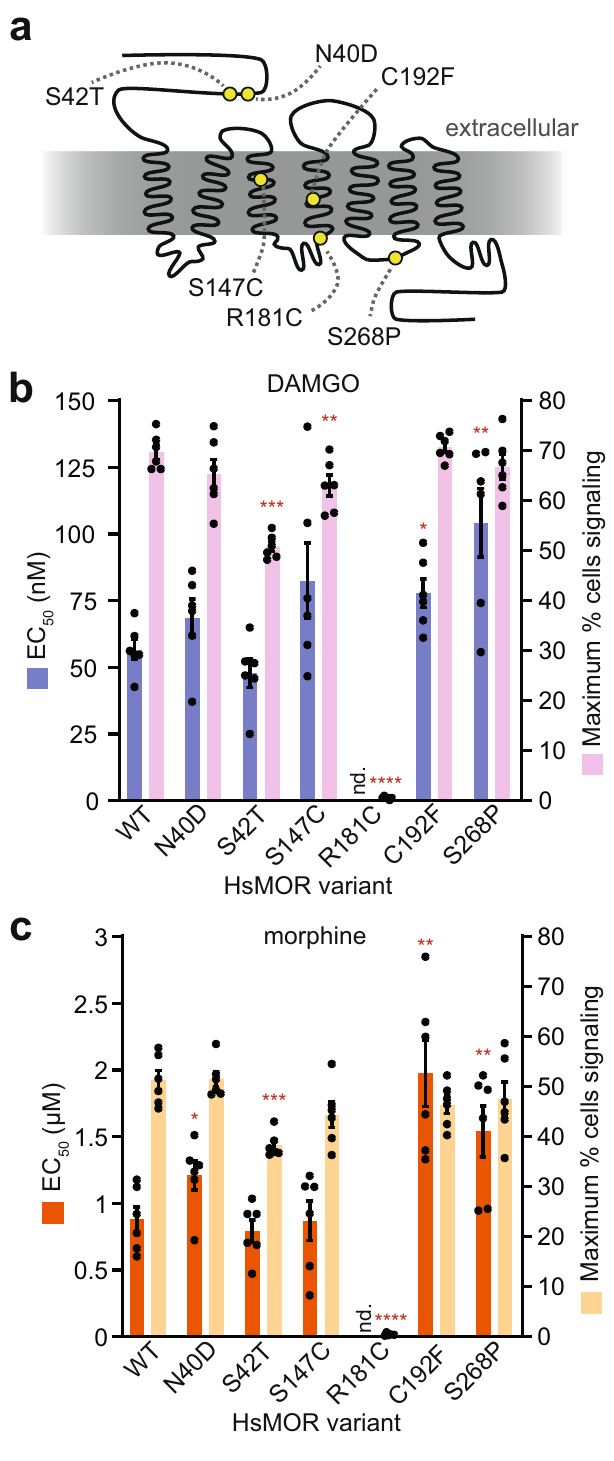
Fig. 4 The effects of HsMOR missense mutations on opioid biosensor activity. a HsMOR snake plot with previously identi fi ed missense mutations. Biosensors based on these mutants were assayed for DAMGO response ( b ), or morphine response ( c ), by fl ow cytometry. Paired one-way ANOVAs of DAMGO pEC 50 s and maximum percentage of cells signaling: n = 6 biologically independent experiments, >2956 cells/condition/ replicate; P = 0.0002 and P < 0.0001 respectively; Dunnett ’ s tests against WT shown. Paired one-way ANOVAs of morphine pEC 50 s and maximum percentage of cells signaling: n = 6 biologically independent experiments, >4761 cells/condition/replicate; P = 0.0033 and P < 0.0001 respectively; Dunnett ’ s tests against WT shown. Data presented as mean + / − SEM.